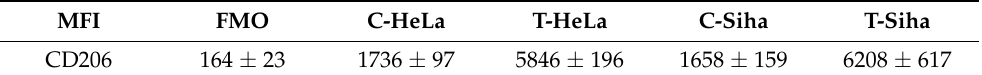
Table 3. MFI of CD206.